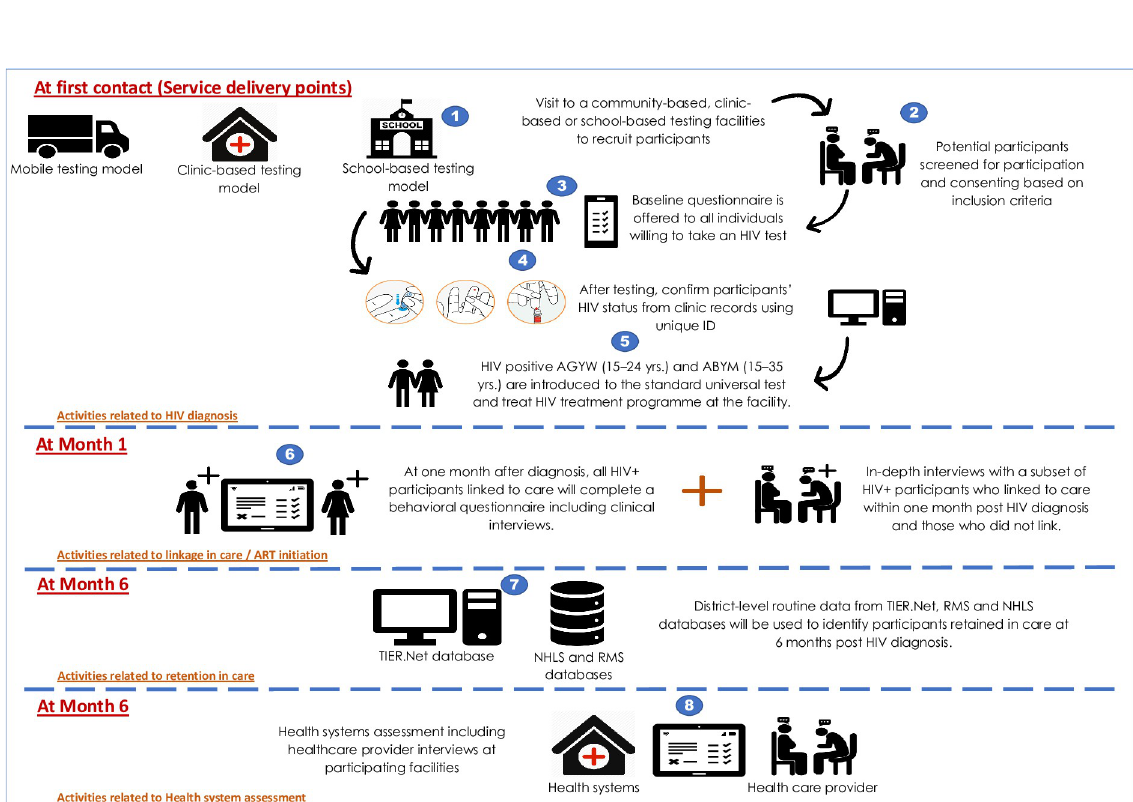
Fig 1. An illustration of the study activities for the SHeS’Cap-Linkage study in uMgungundlovu district, KwaZulu-Natal, 2022.